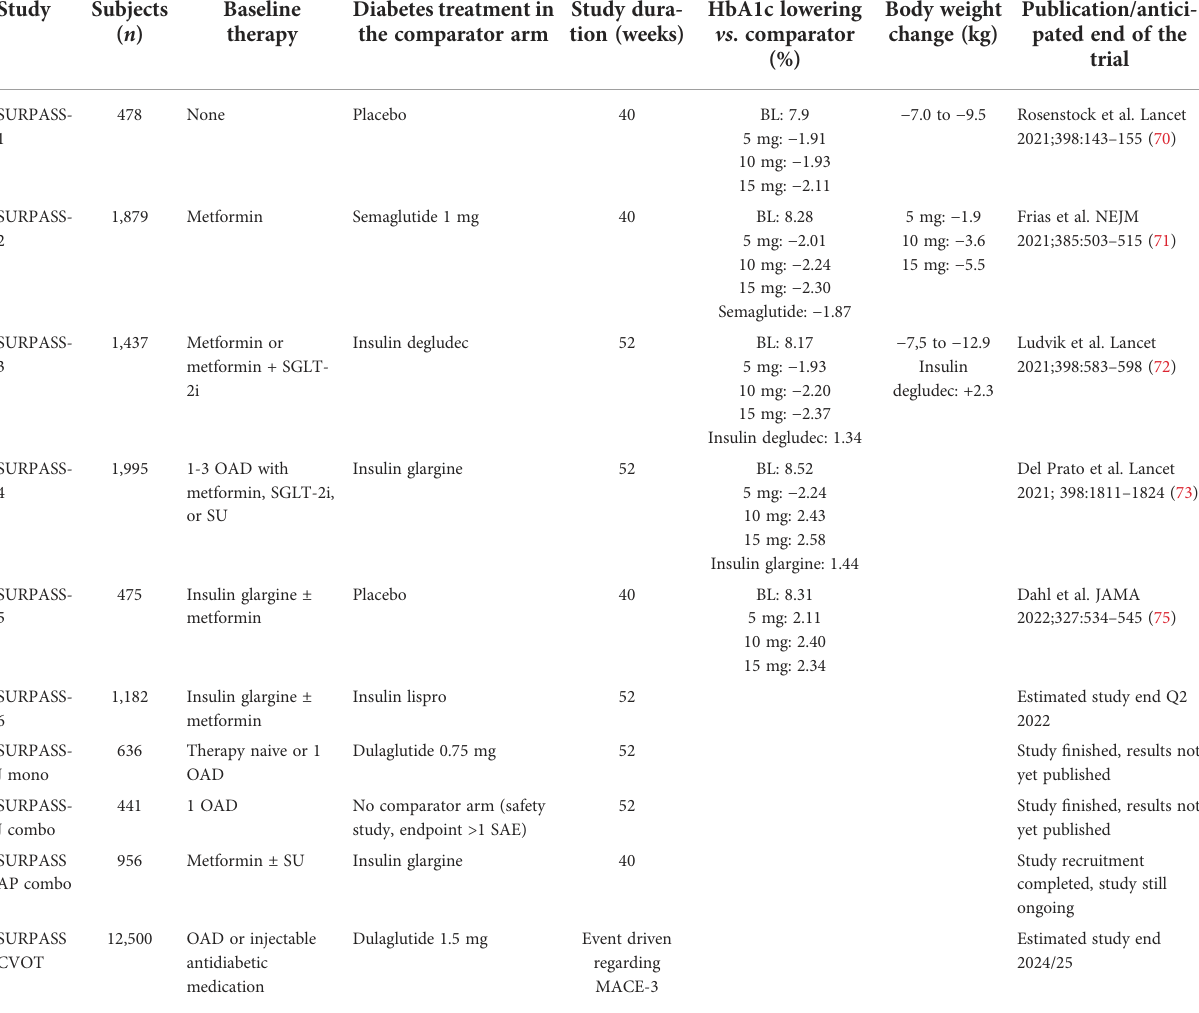
TABLE 2 Overview of the SURPASS clinical trial program with tirzepatide in the therapy of type 2 diabetes.